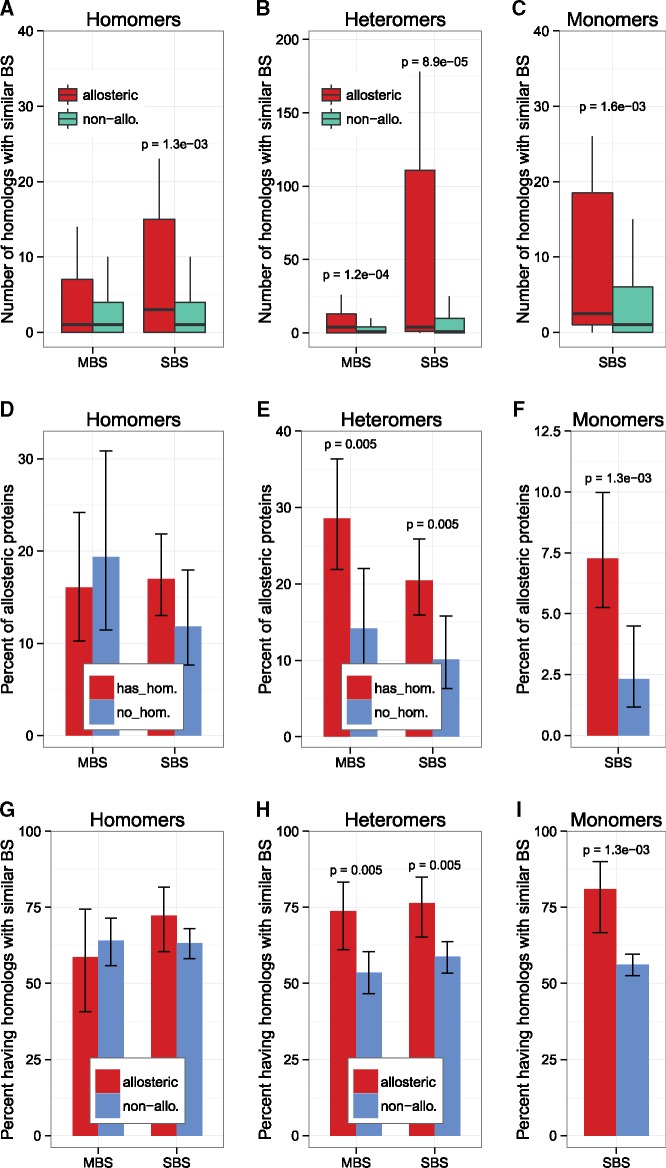
The presence of homologs with similar binding sites is a driving force of the evolution of allostery. (A–C) Except MBS homomers, proteins of allosteric complexes have many more homologs with similar BSs than nonallosteric proteins of the same complex type (P ≪ 0.05, one-sided Wilcoxon tests). (D–F) Except homomers, the frequency of allosteric proteins is ∼2× higher in proteins that have a homolog with a similar binding site, irrespectively of quaternary structure (one-sided tests of proportions; whiskers are 95% CI). In MBS homomers, proteins without homologs have a high frequency of allostery. (G–I) The opposite pattern, i.e. the frequency of homologs with similar binding sites in allosteric proteins shows a much smaller effect size (although similar significance): the percent of proteins having a homolog with a similar binding site is only 20–30% higher among allosteric proteins, irrespectively of their quaternary structure (one-sided tests of proportions, whiskers are 95% CI). These results indicate that primarily the presence of homologs drives the evolution of allostery, and not that allostery drives the emergence of homologs, although both processes are likely to contribute to the pattern.